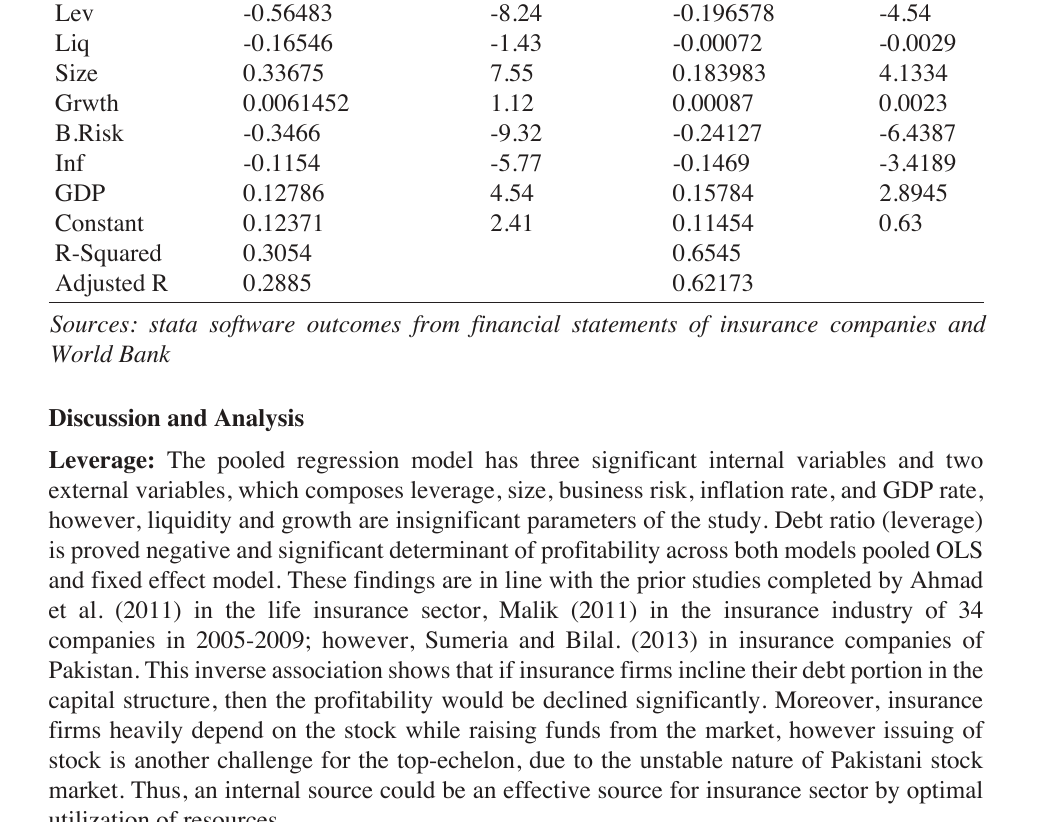
Factors of Profitability using Pooled OLS and Fixed Effect